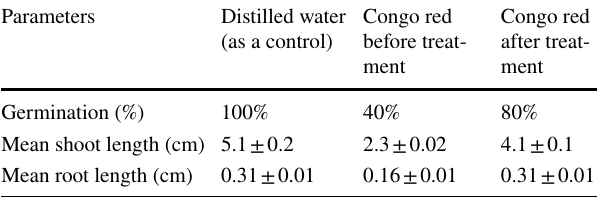
Table 2 Phytotoxicity of Congo red before and after biodegradation